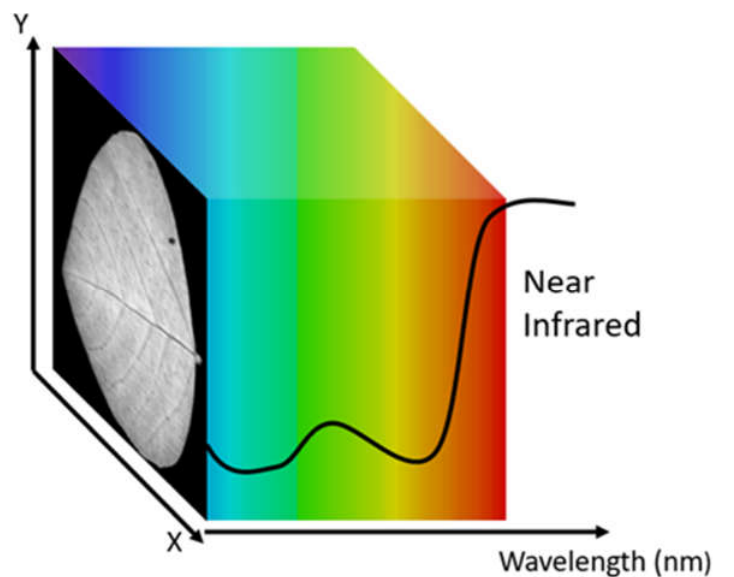
Figure 1. A visual illustration of a hyperspectral image cube (hypercube). The X- and Y-axes corre- spond to the image’s spatial width and height, respectively; the third dimension is the spectral di- mension.